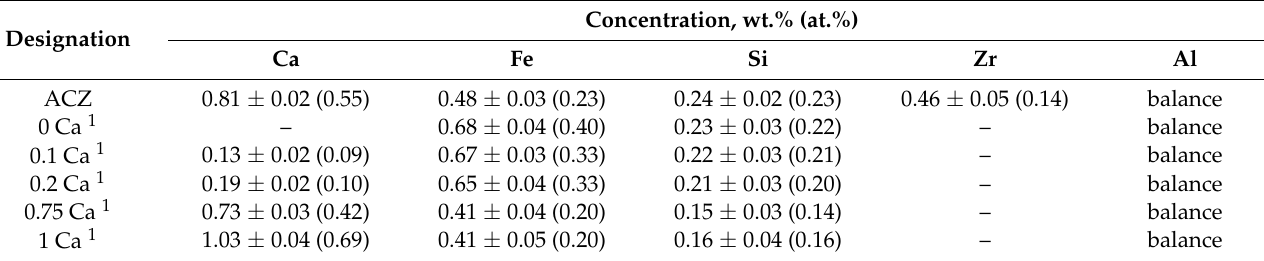
Figure 1. As-cast wire rod (12 mm) and cold rolled strip ( a ), and ( b ) cold drawn wire of ACZ alloy. Table 1. Chemical compositions of experimental Table 2. Annealing regimes for electromagnetic casting (EMC) rod, strip and wire.